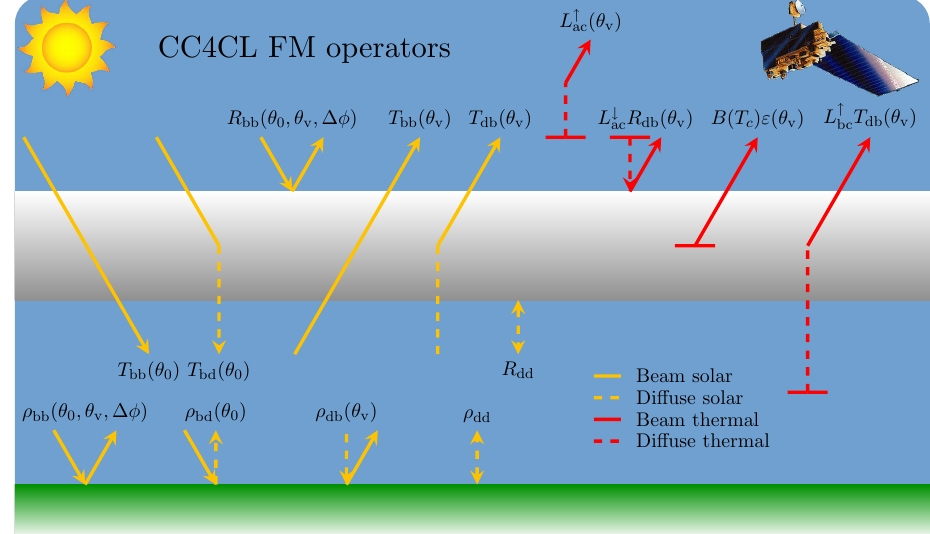
Figure 1. A schematic diagram of the ORAC cloud reflectance, transmission and emission operators; surface reflectance operators; and clear- sky emission profiles. Yellow arrows indicate reflectance and transmission operators and red arrows indicate emission. Solid lines indicate beam transport and the dashed lines indicate diffuse transport.